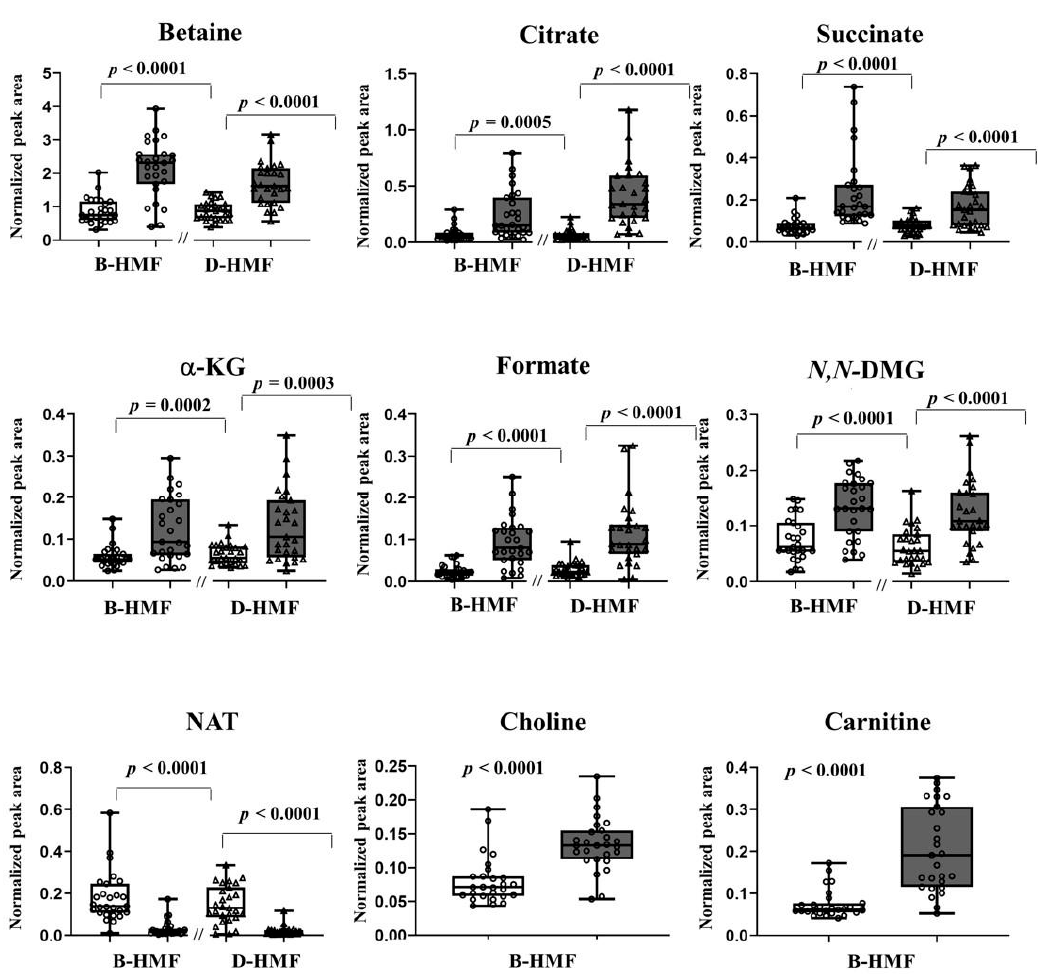
Figure 3. Box-plots indicating relative urine concentrations of discriminant metabolites (fold change > 2; p < 0.001) observed between the samples collected at T0 (white) and T1 (grey): ● , B-HMF: ▲ , D-HMF.